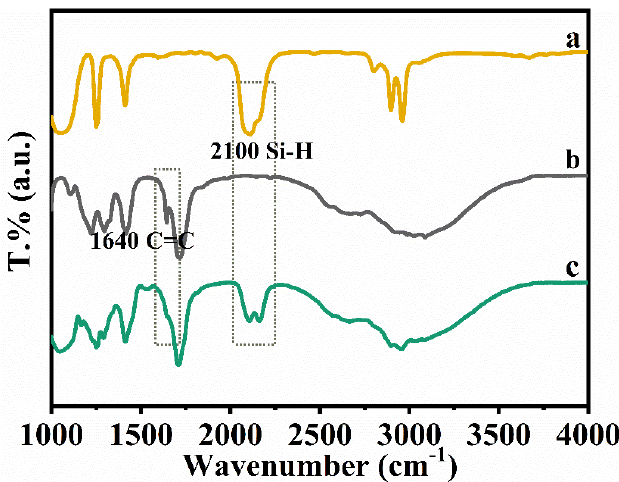
Figure 1. FT–IR spectra of a: PMS, b: 3–butenoic acid, and c: